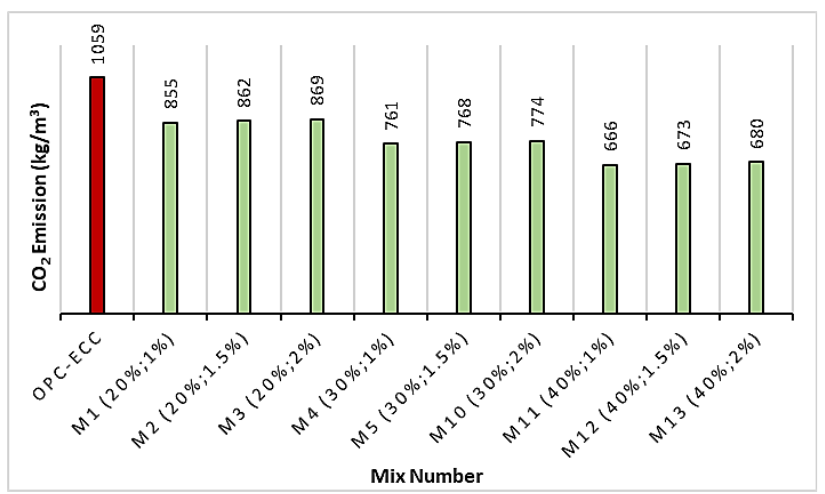
Figure 14. CO 2 emission values of POFA-ECC mixes.